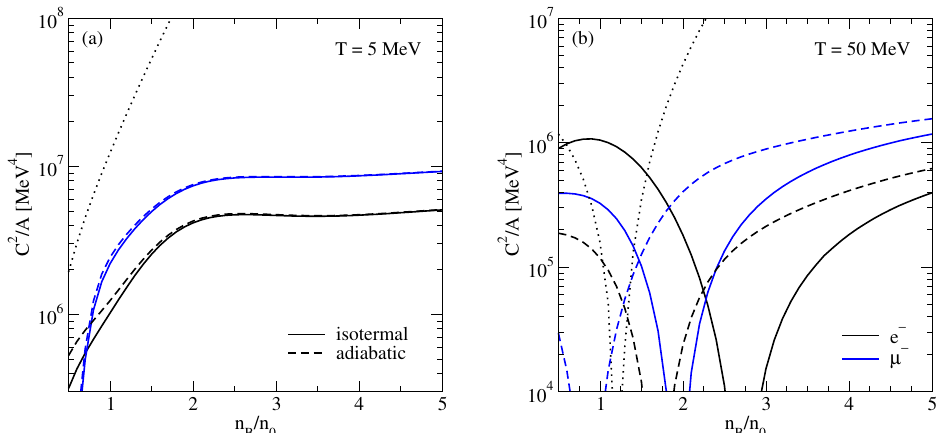
Figure 6. The susceptibilities C 2 / A 1 and C 2 / A 2 corresponding to electronic and muonic bulk 2 1 viscosities as functions of the baryon density for neutrino-transparent matter ( a ) and neutrino- trapped matter ( b ). The solid lines show isothermal susceptibilities, and the dashed lines show the adiabatic susceptibilities. The dotted lines show the nonrelativistic approximation to the isothermal C 2 / A 1 1